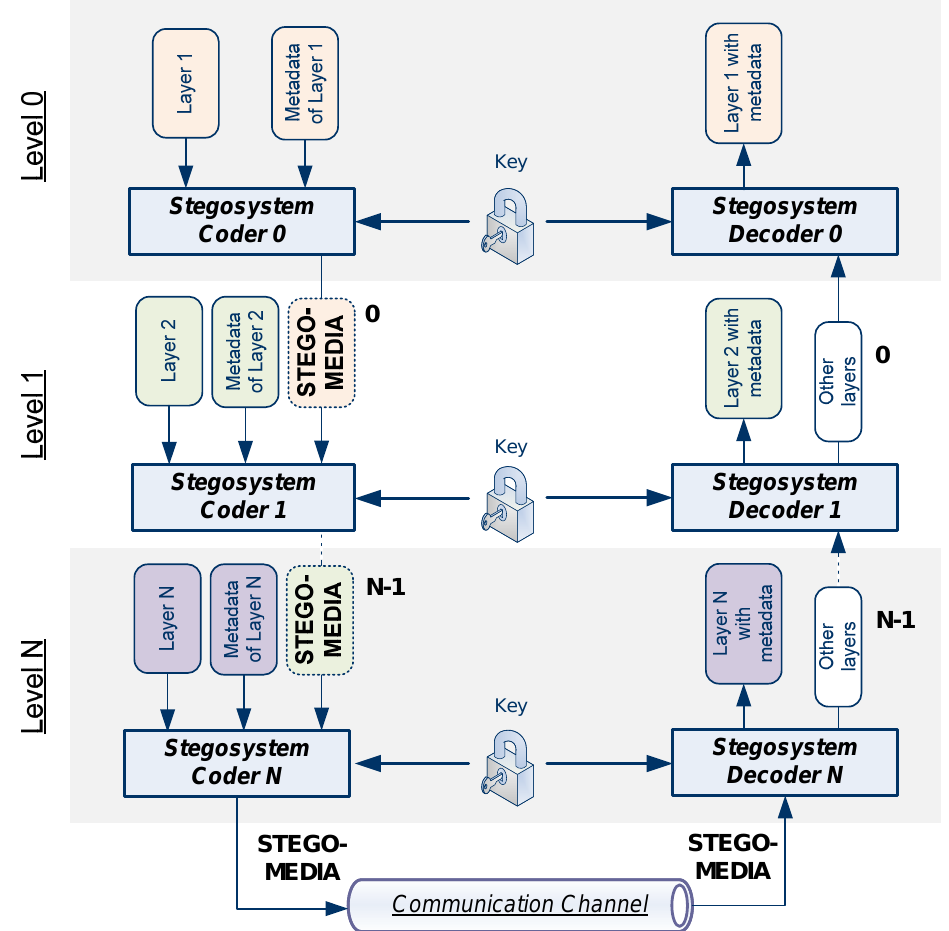
Fig. 5. Concatenated steganographic model appropriate for